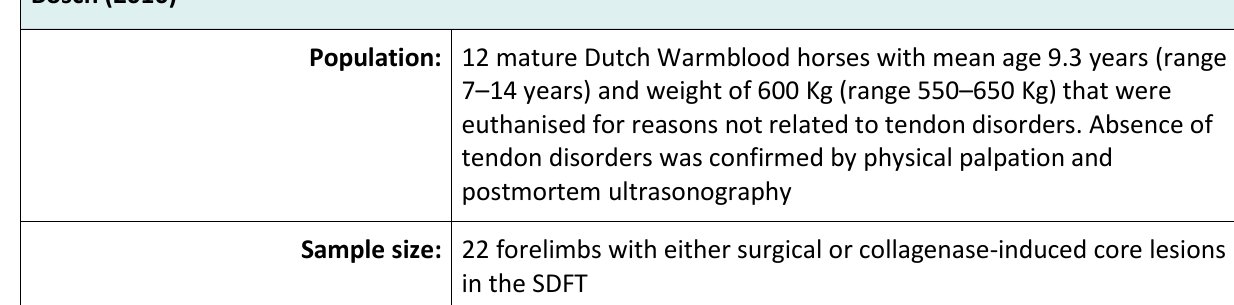
Population: 12 mature Dutch Warmblood horses with mean age 9.3 years